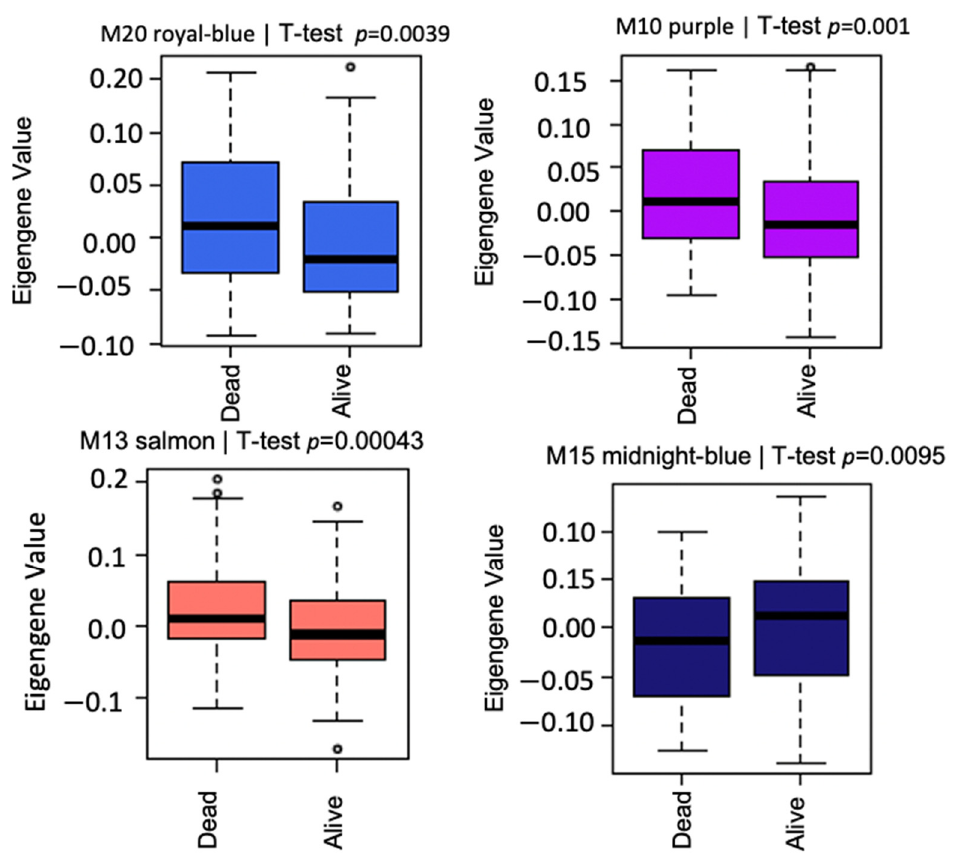
Figure 4. Box plots of differential expression patterns of module eigengenes across MM patient samples. Each color of the box represents the module and the associated p -values. Royalblue,